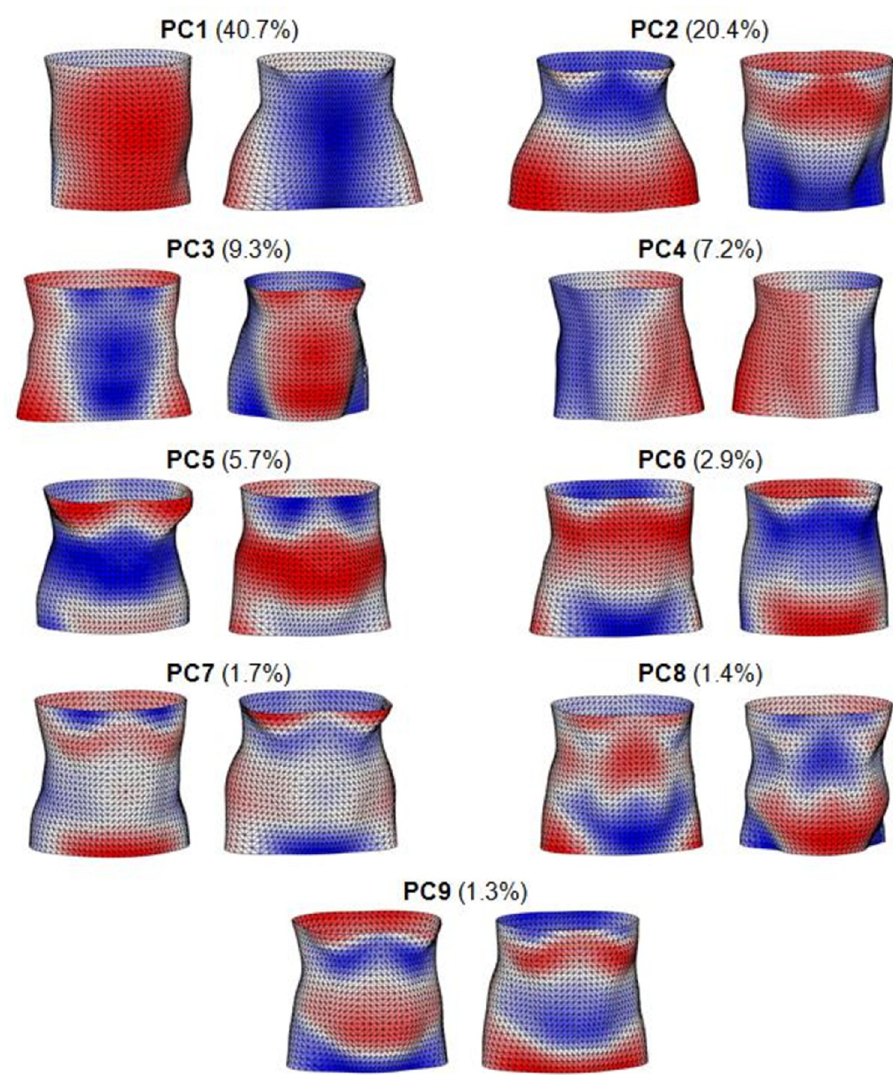
Fig 3. Torso shape principal components (PCs). First 9 PCs capturing 90.6% of variation in torso shape in the LIFE-Adult cohort, shown as the maximum positive (left) and negative (right) deviations from the sample mean. Blue and red regions represent areas that protrude less, or more than the average torso shape,